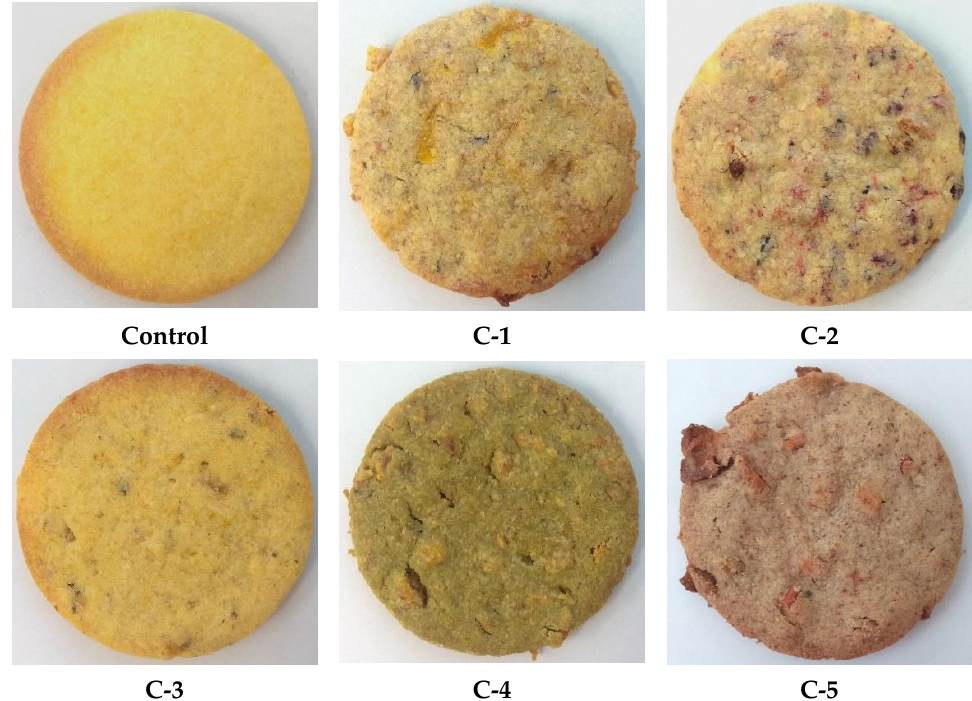
Figure 1. Baked cookies supplemented by non-traditional flours and edible flowers according to recipe presented in Table 1.